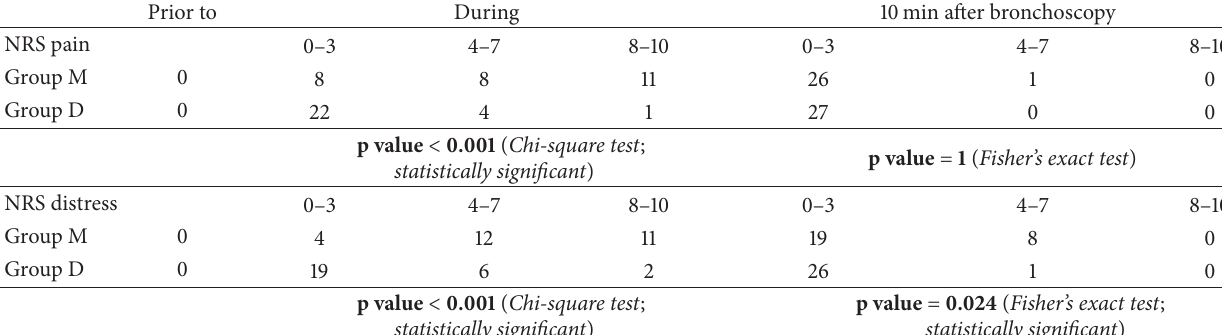
Table 5: Numerical rating scale for pain and distress.